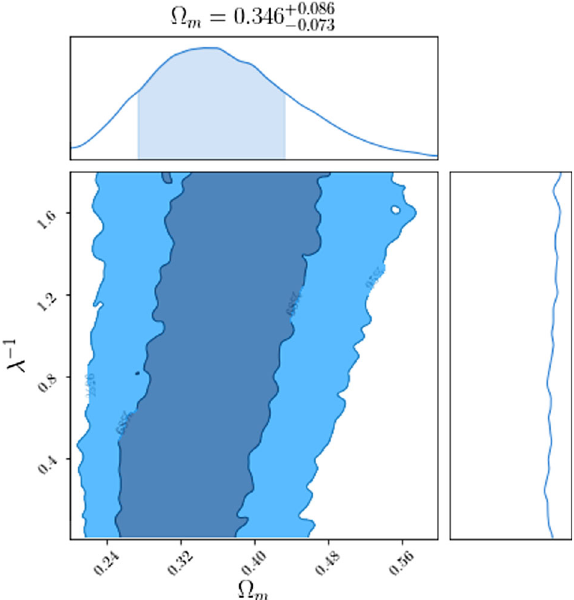
Fig. 4 MCMC simulations for the f ( R ) model with n = 1, con- sidering [ f σ 8 ] ( z ) data and the flat priors: λ − 1 ∈ [ 0 . 001 , 2 . 0 ] and Ω ∈ [ 0 . 15 , 0 . 3 ] m 0